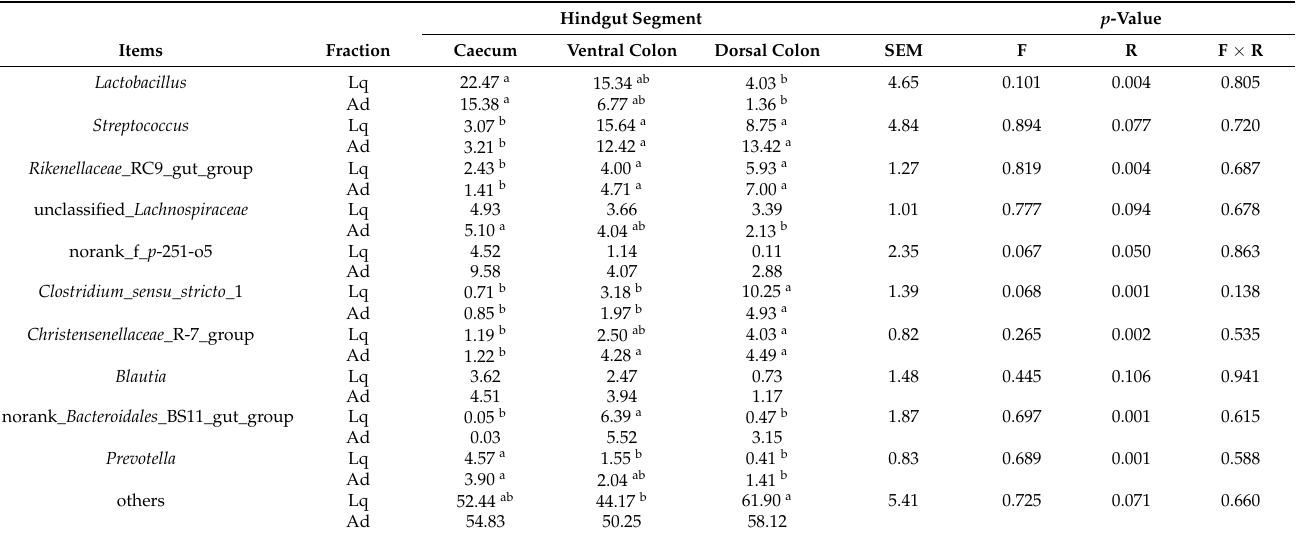
Table 4. The relative abundance of bacterial community composition at the genus level (top 10) in the liquid phase (Lq) and adherent fraction (Ad) within the donkey caeco-colic ecosystem. Hindgut Segment p -Value